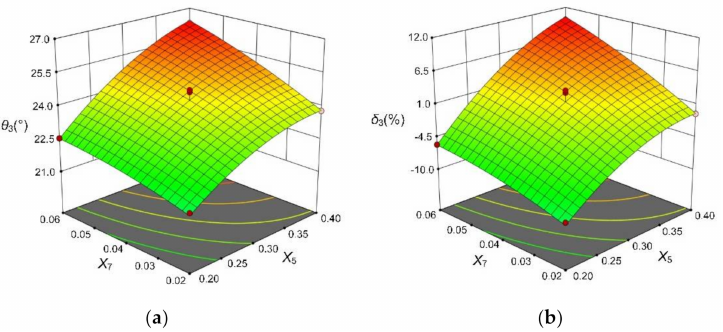
Figure 8. The influence of significant interaction term on the AOR and AOR error. ( a ) the influence of X 5 X 7 on the AOR; ( b ) the influence of X 5 X 7 on the AOR error.